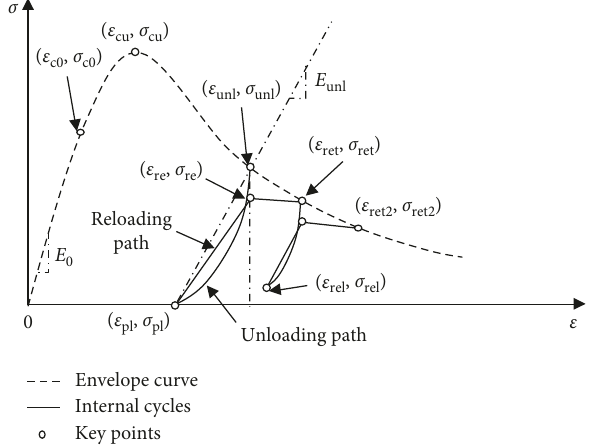
Figure 10: Key parameters’ definition of cyclic stress-strain of